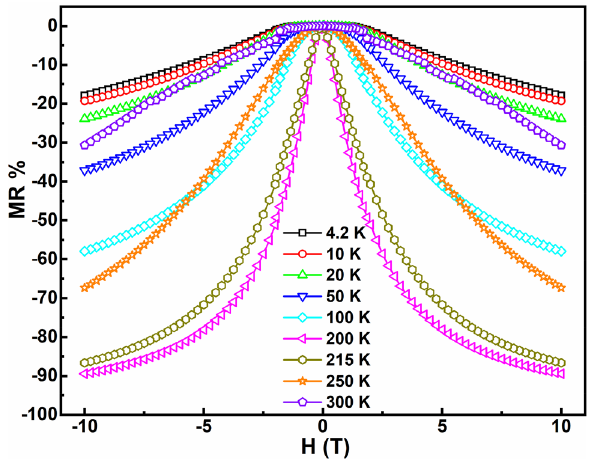
Figure 12. MR % obtained from magnetotransport measurement for PSMO/PCMO/STO ultra-thin heterostructure at different temperatures in the magnetic field range of ± 10 T.